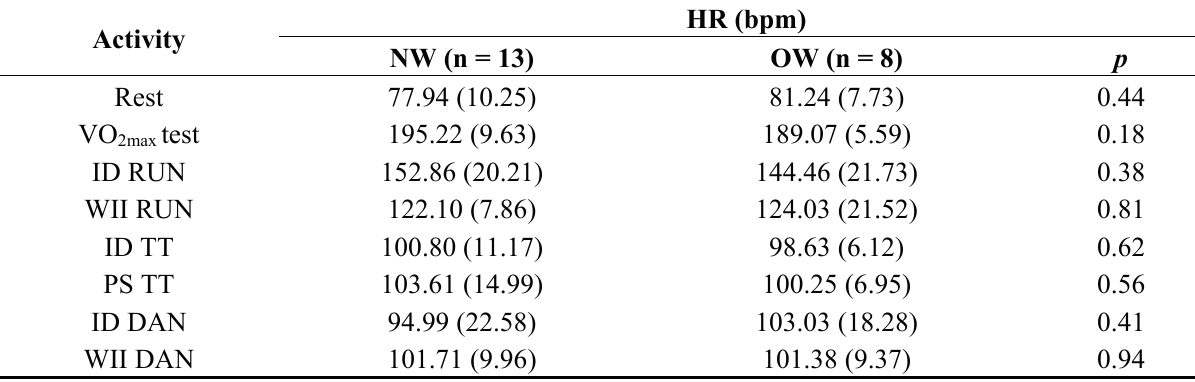
Table 4. Heart rate by weight status for each condition.